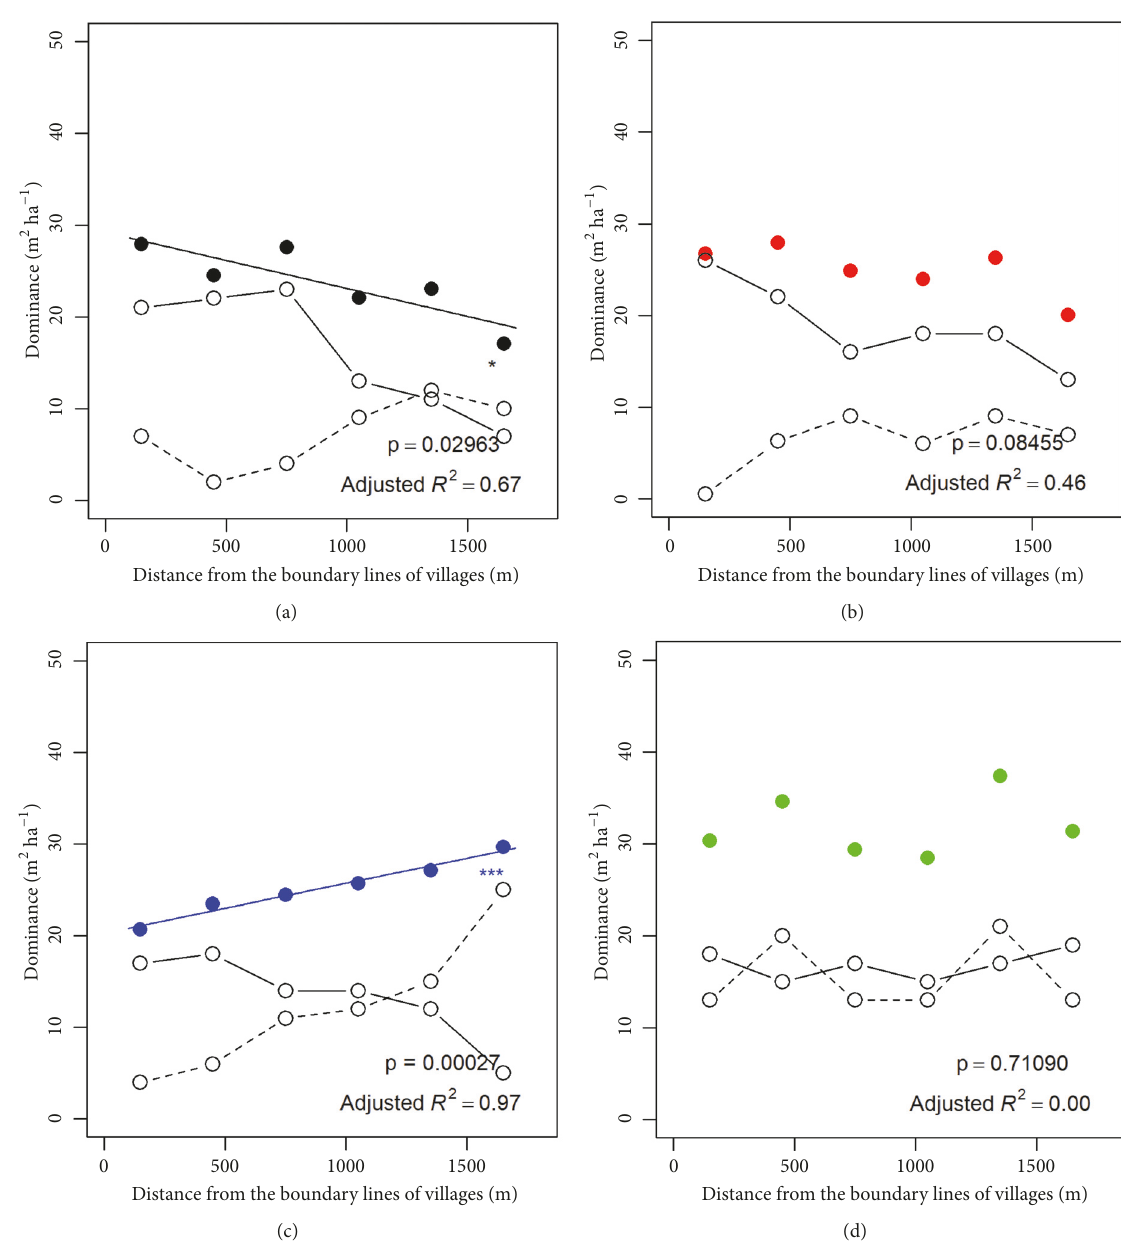
Figure6:Dominance(basalarea)ofspeciesasafunctionofthedistancefromthevillageboundaries.Inthefigure,solidcircleswithsolidlines, hollow circles with solid lines, and hollow circle with dashed lines indicate total dominance, dominance of Shorea robusta, and dominance of other species except for Shorea robusta, respectively. (a) Janajagaran BZCF: significant (p < 0.05), (b) Musharni Mai BZCF: nonsignificant (p > 0.05), (c) Radha Krishna BZCF: significant (p < 0.001), and (d) Parsa Wildlife Reserve: nonsignificant (p >